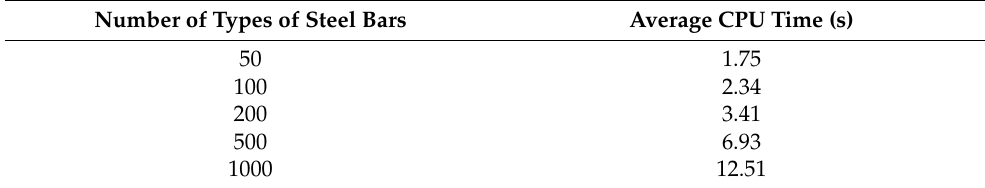
Table 7. Data for the required numbers of steel bars of diameter 12 mm and diameter 18